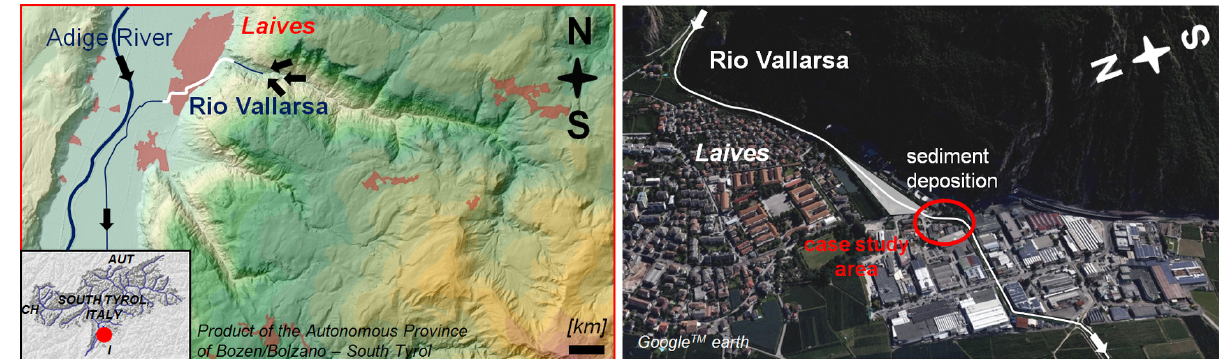
Figure 3. (Left) overview of the Rio Vallarsa catchment and the Adige valley at the village of Laives (Italy); the colour scheme characterises an elevation model with a 2.5m interval. (Right) track of the Rio Vallarsa torrent channel through settlement and commercial area in the south-western part of Laives; location of the case study area on the alluvial